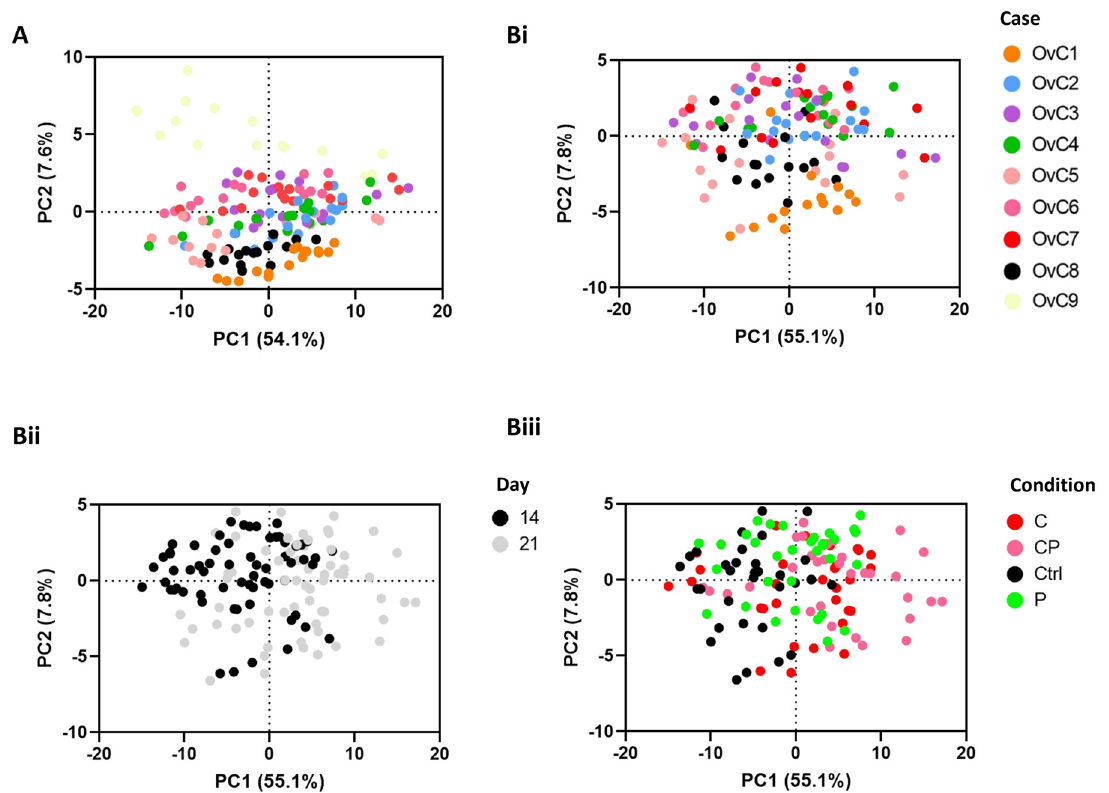
Figure 4. Semi-targeted exometabolome analysis reveals metabolic heterogeneity among serous carcinoma-derived explant cultures. Multivariate data analysis using principal component analysis (PCA) reveals clustering trends by OvC case ( A ) across all samples, including untreated controls (Ctrl) and treated conditions, at days 14 and 21, and ( Bi ) between high-grade serous carcinoma (HGSC)-derived explant cultures (i.e., excluding OvC9). The latter also reveals ( Bii ) a slight trend by timepoint and ( Biii ) no clear separation by treatment group (C: carboplatin, P: paclitaxel, CP: drug